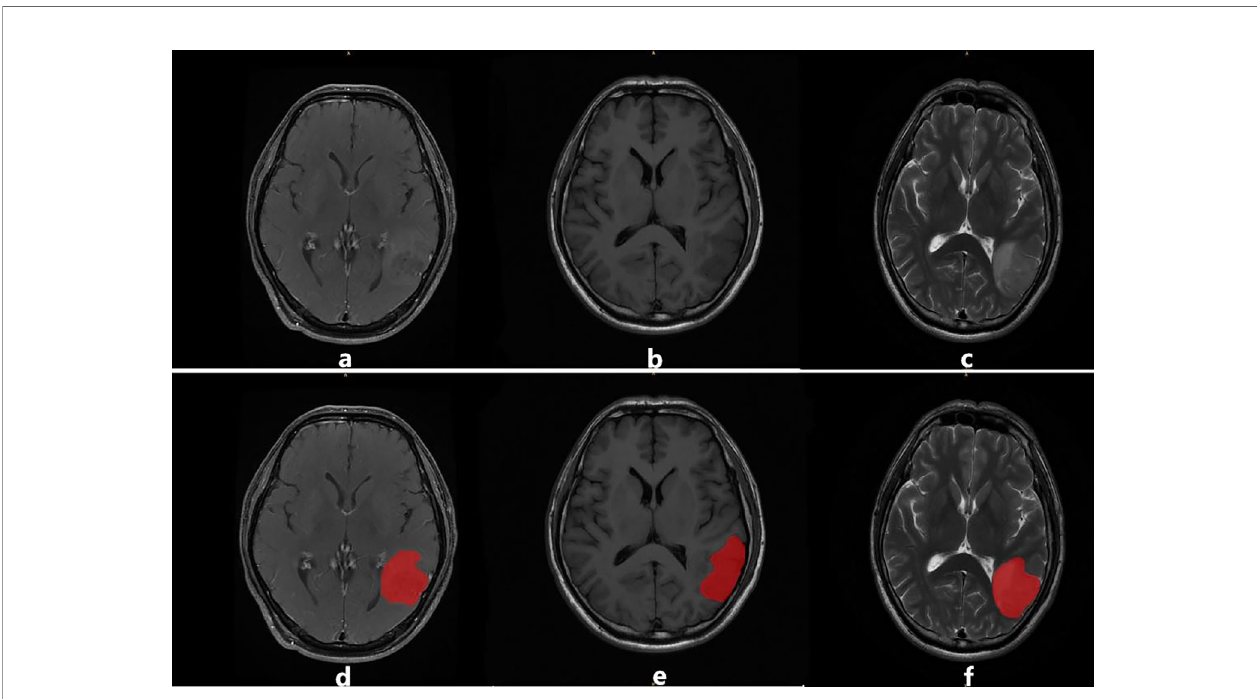
FIGURE 2 | An example of image segmentation: (A – C) illustrate T1CE, T1WI, and T2WI sequences, respectively. Images (D – F) illustrate the region of interest (ROI) in red delineated by the radiologists for feature